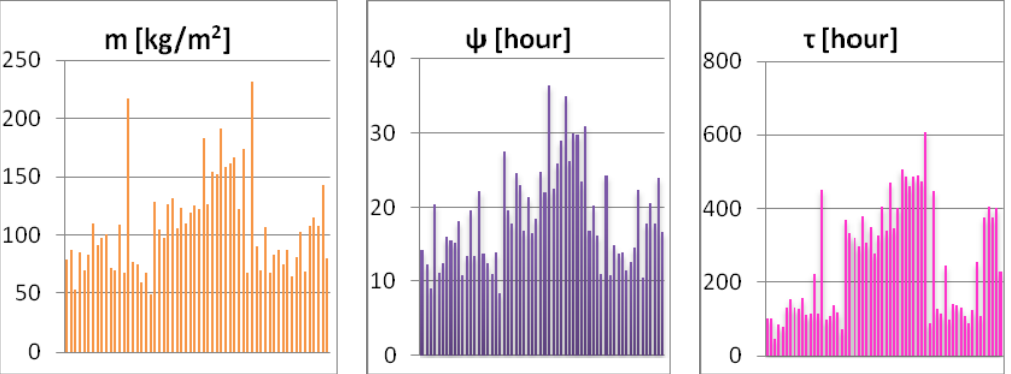
Figure 2. Mass per unit area, phase shift of thermal oscillation, and relaxation time of external